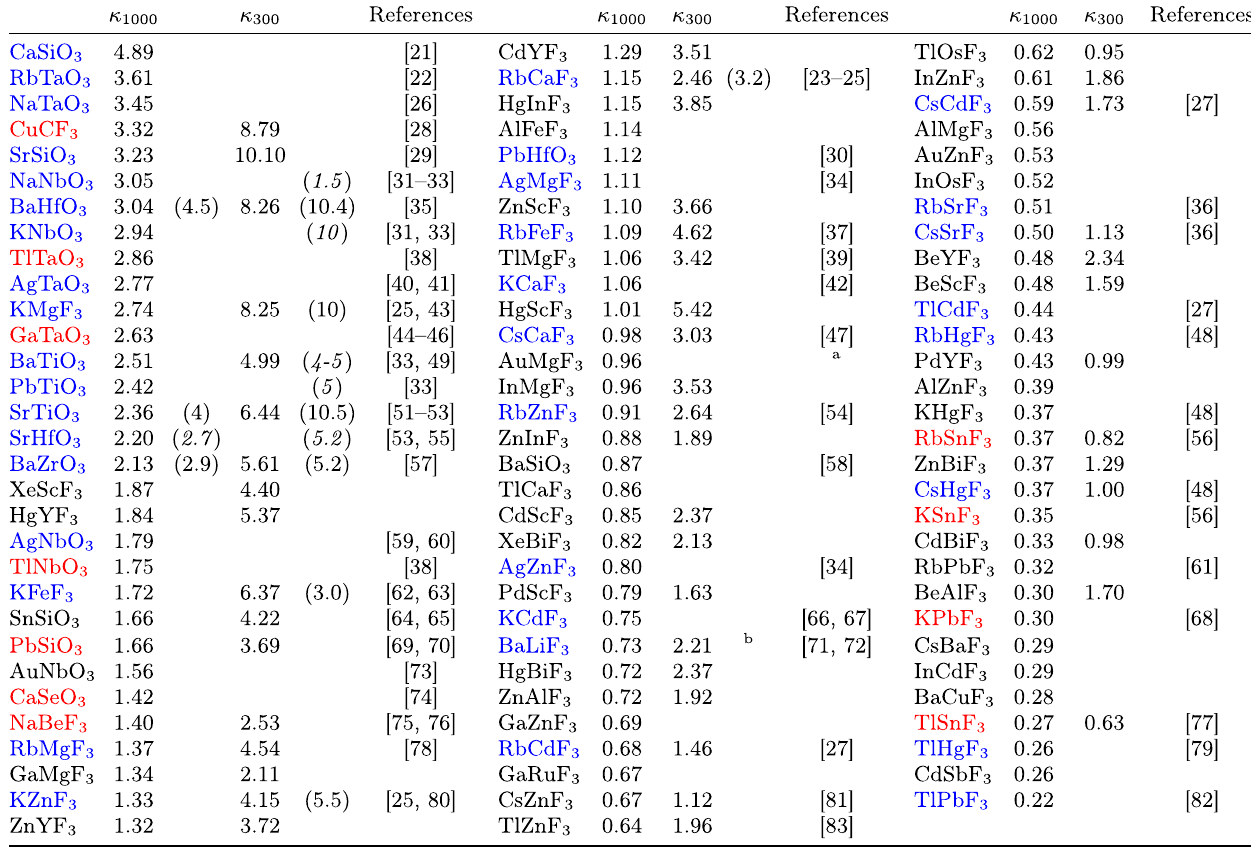
FIG. 2. List of cubic perovskites found to be mechanically stable at 1000 K and their corresponding computed lattice thermal conductivity (in W m − 1 K − 1 ). We also report the computed lattice thermal conductivity at 300 K (in W m − 1 K − 1 ) when we obtain stability at that temperature. We highlight in blue the compounds that are experimentally reported in the ideal cubic perovskite structure, and in red those that are reported only in nonperovskite structures (references provided in the table). When no reference is provided, no mention of the compound in this stoichiometry has been found in the experimental literature. Experimental measurements of the thermal conductivity are reported in parentheses, and in italics when the structure is not